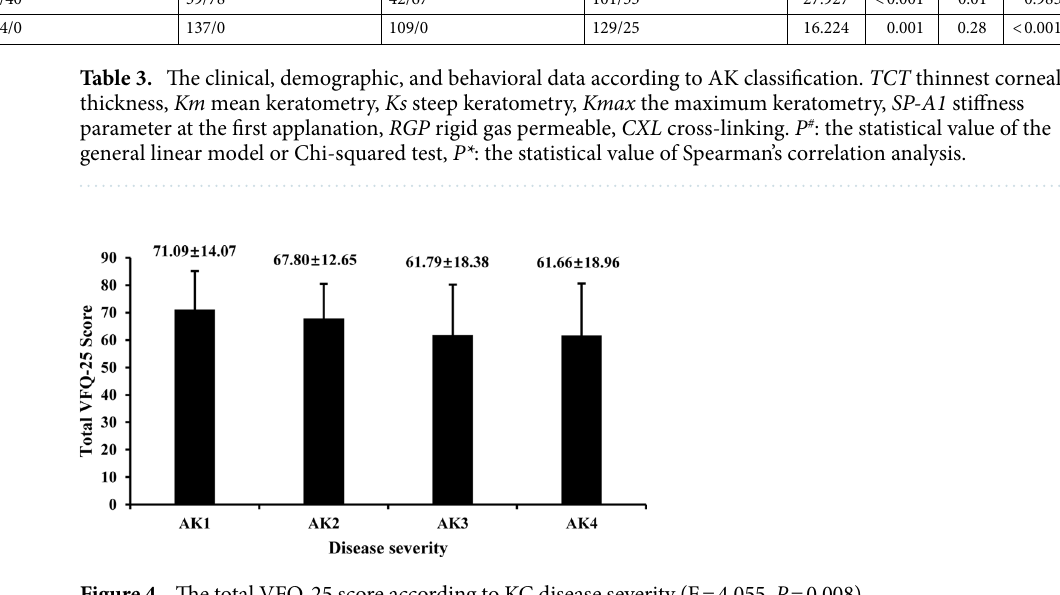
Figure 4. The total VFQ-25 score according to KC disease severity (F = 4.055, P =